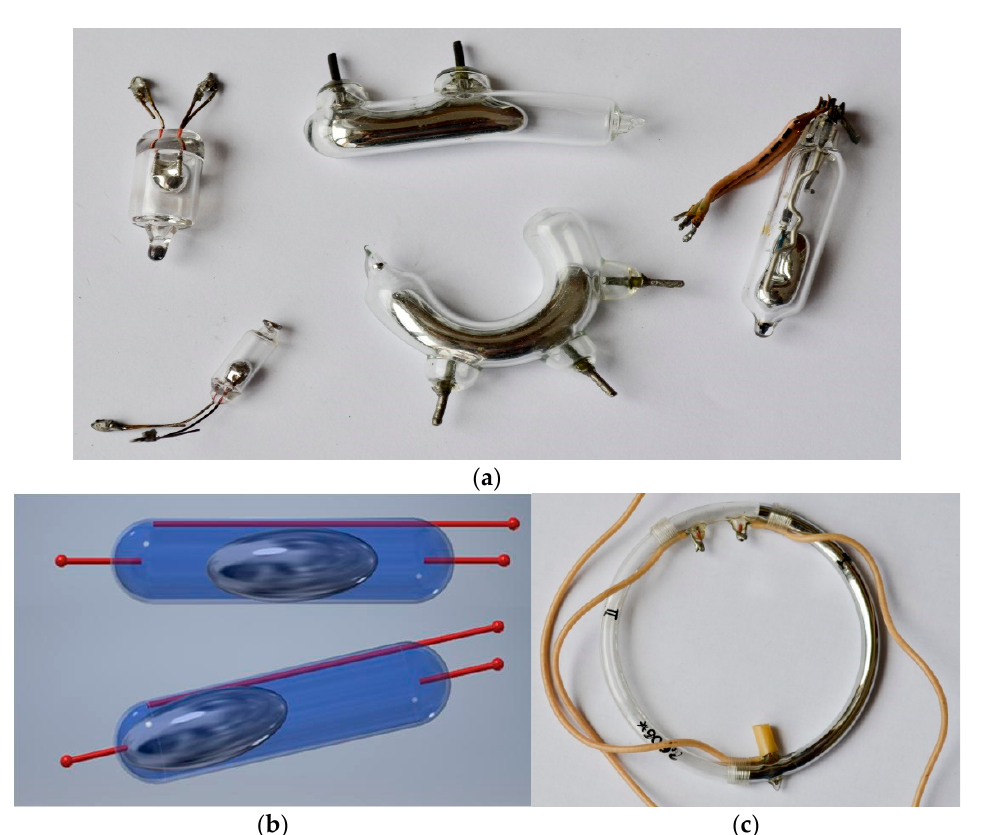
Figure 1. Mercury tilt sensors: ( a ) various types of contact switches; ( b ) principle of operation; ( c ) sensor with resistive wire.